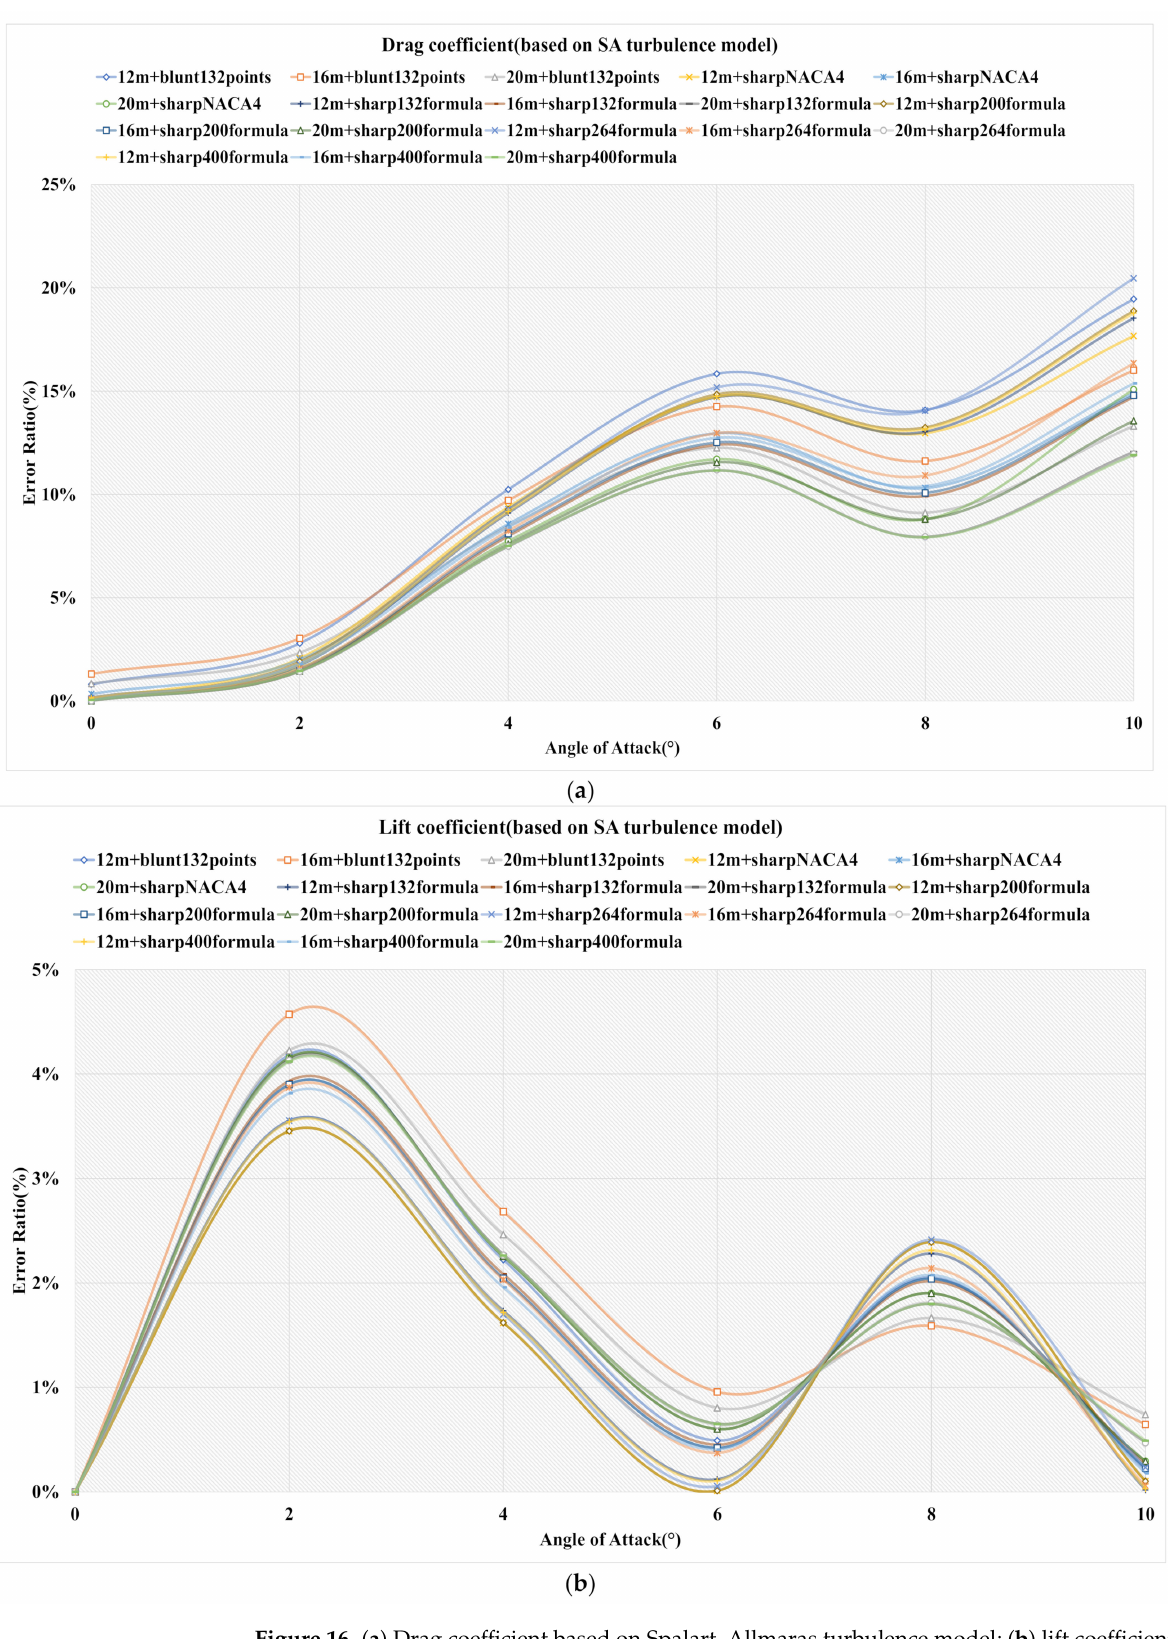
Figure 16. ( a ) Drag coefficient based on Spalart–Allmaras turbulence model; ( b ) lift coefficient based on Spalart–Allmaras turbulence